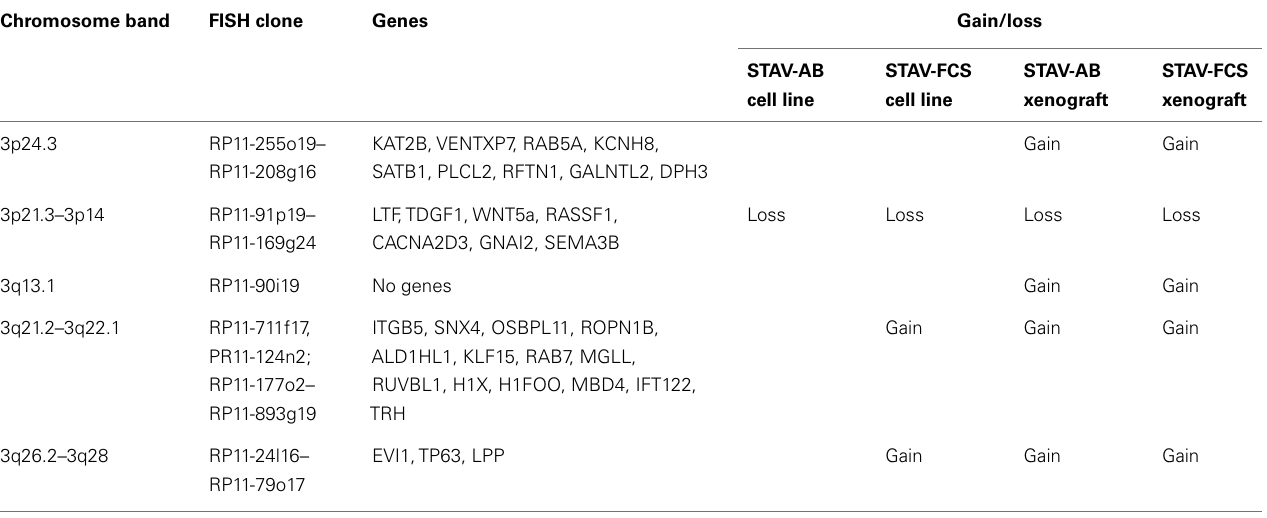
Table 3 |Volume density of blood vessels in xenografts. Distance from tumor